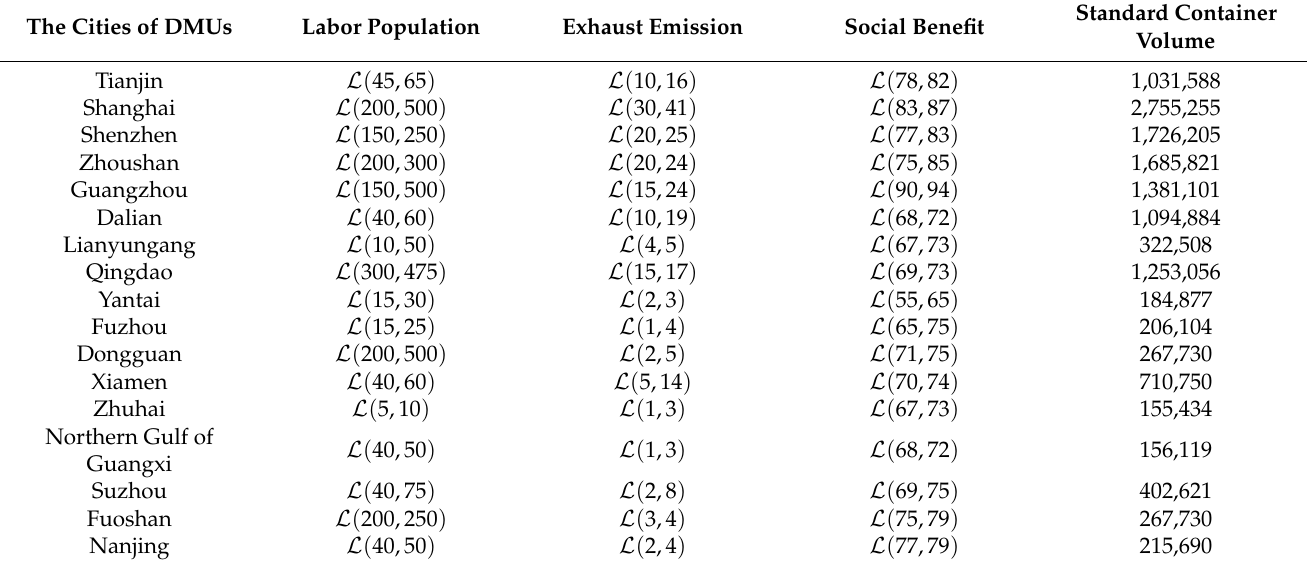
Table 2. The inputs and outputs of the marine supply chain in 17 coastal cities in China,